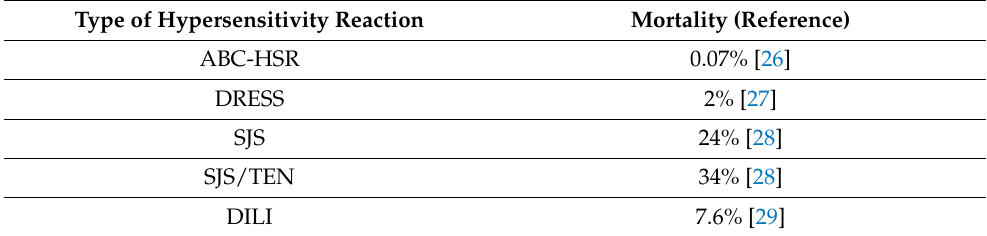
Table 4. Mortality rates of hypersensitivity reactions.